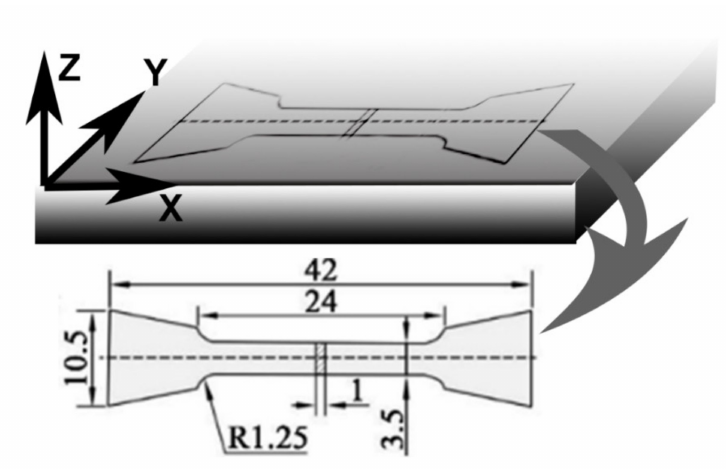
Figure 1. The dimension (in mm) of the tensile samples, Z was the building